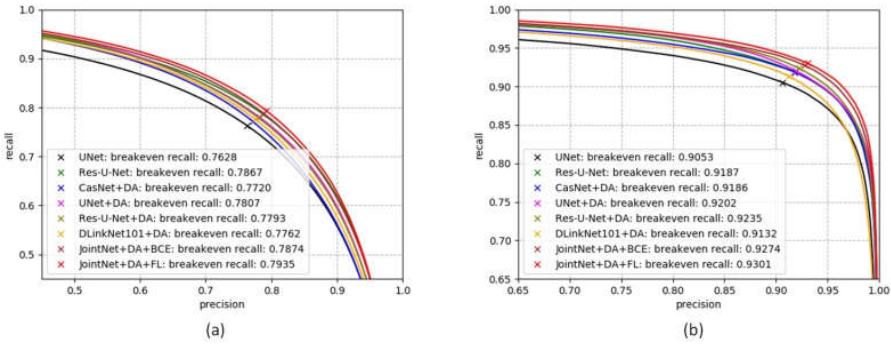
Figure 7. Precision/recall plots of convolution neural networks (CNNs) performance on Massachusetts road datasets: ( a ) The standard precision/recall plots. ( b ) The relaxed ( ρ = 3) precision/recall plots. Table 3. Evaluation results on Massachusetts road datasets